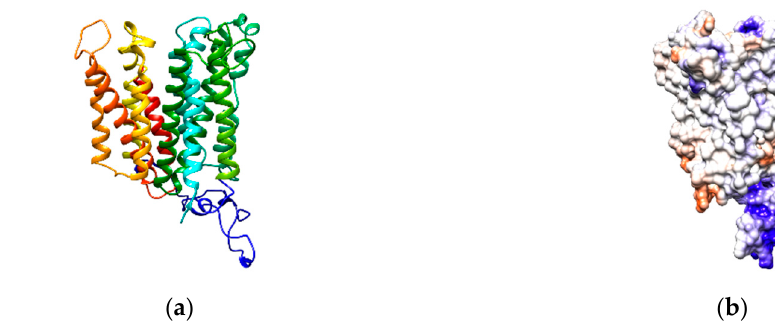
Figure 10. Structural model of RFVT2. ( a ) Lateral view of the ribbon diagram of the RFVT2. The protein is constituted by 11 transmembrane α -helices and a big intracellular loop which connect the transmembrane segment 6 with the transmembrane segment 7. The homology model was constructed by the SWISS-MODEL tool using the crystallographic structure of human Equilibrative Nucleoside Transporter 1 (ENT1) (PDB code 6OB6) as a template. ( b ) Columbic surface coloring of a space filled diagram of RFVT2 homology model. Molecular graphics was performed with UCSF Chimera [24] .